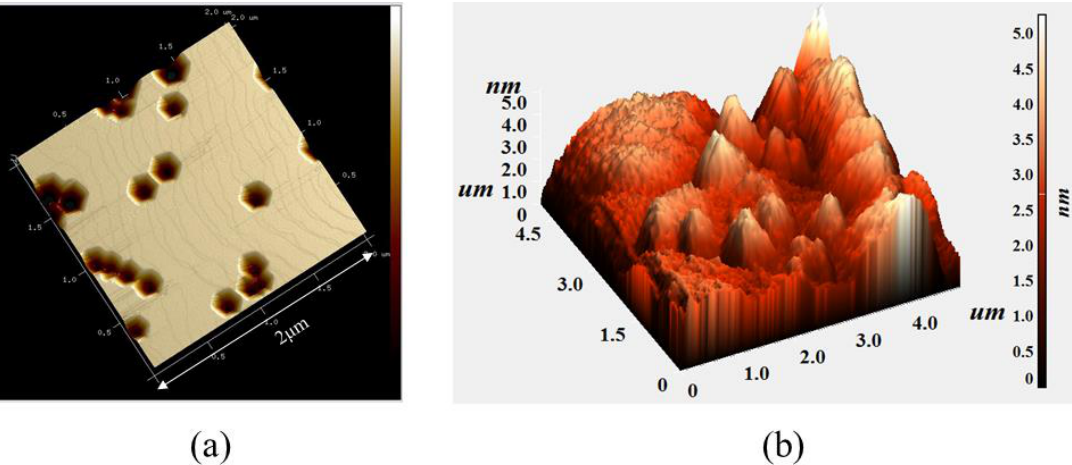
Figure 2. Atomic force microscopy (AFM) image of ( a ) MQWs without upper p-GaN capping layer and ( b ) full LED epitaxy with upper p-GaN capping layer for sample with large V-defects, respectively.